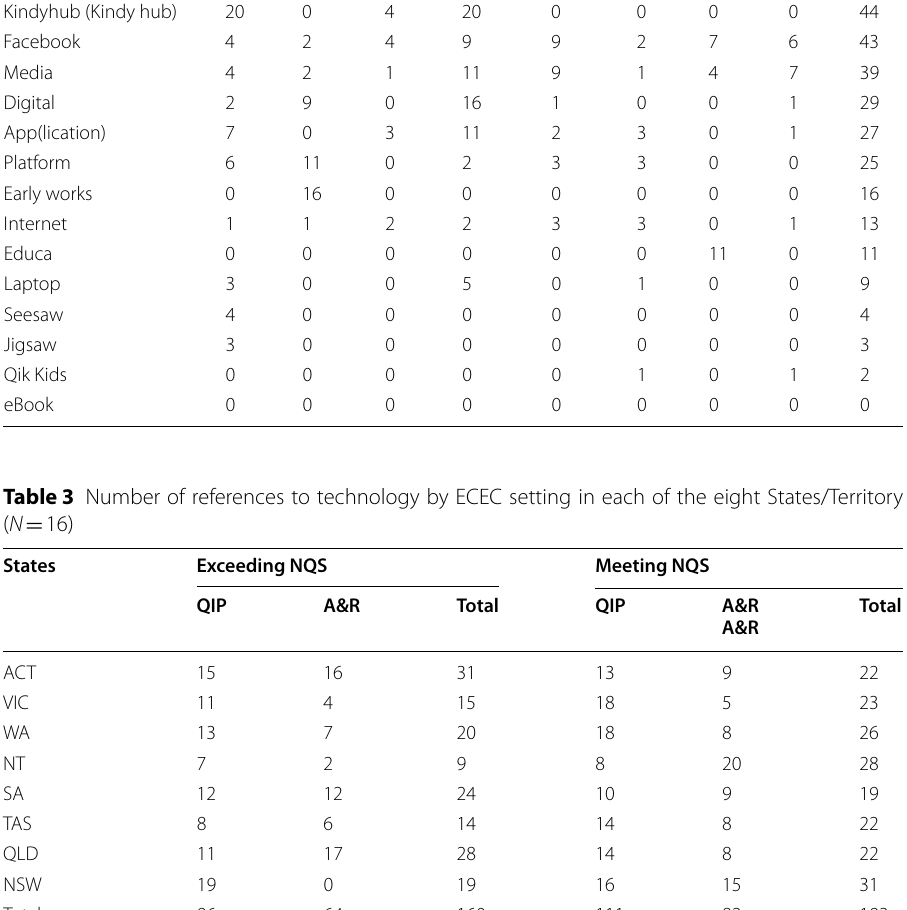
Table 2 Keyword Search Terms and Frequency distribution across the country State/Frequency